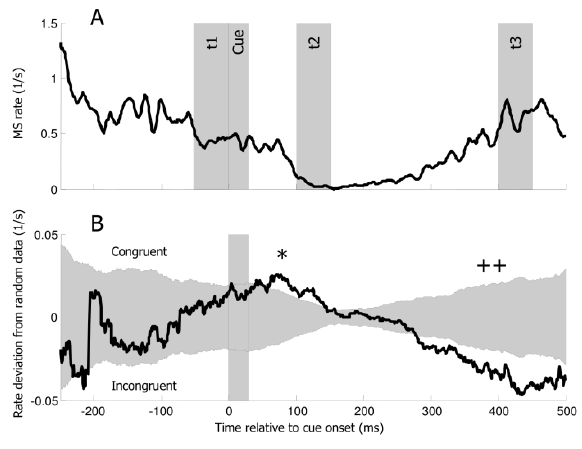
Figure 4. The modulation of microsaccade rates during fixation in a visual predictive cue-target task. This figure was created using the same analysis as in Fig. 3.